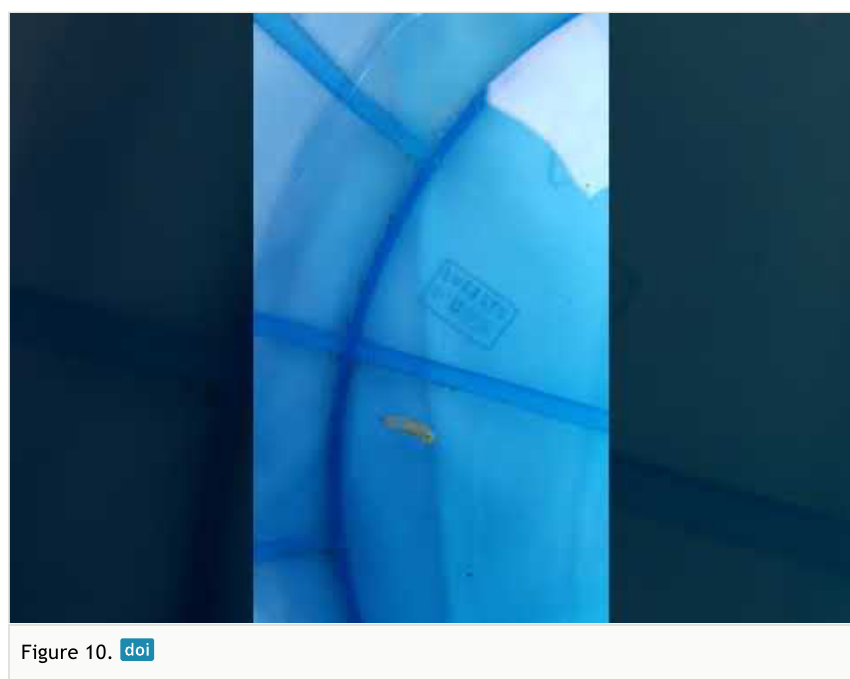
Figure 10. Third instar Caiusa larva collected from a Chiromantis simus (Annandale) nest at Shyamkhola More (West Bengal) in 2018. The video shows the larva pausing its habitual swimming motion, presumably for air intake through the posterior